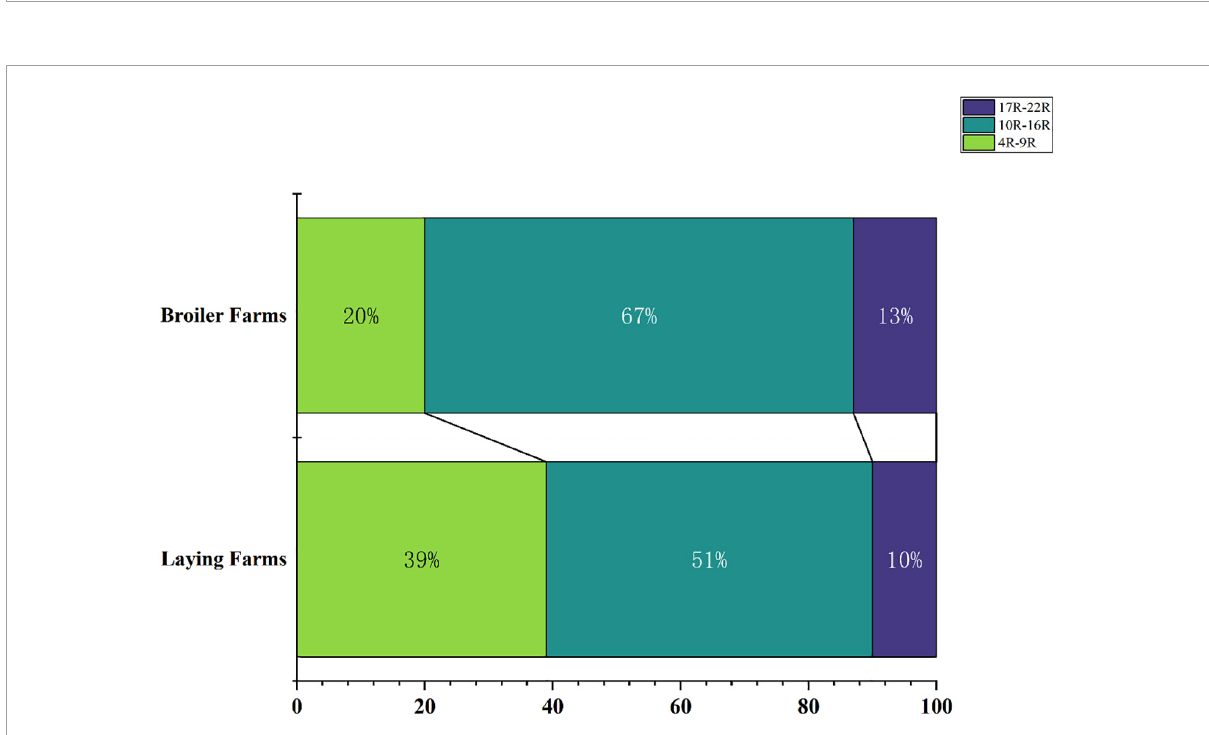
FIGURE5 Proportion of resistant bacteria in different drug resistance situations in broiler farms and laying